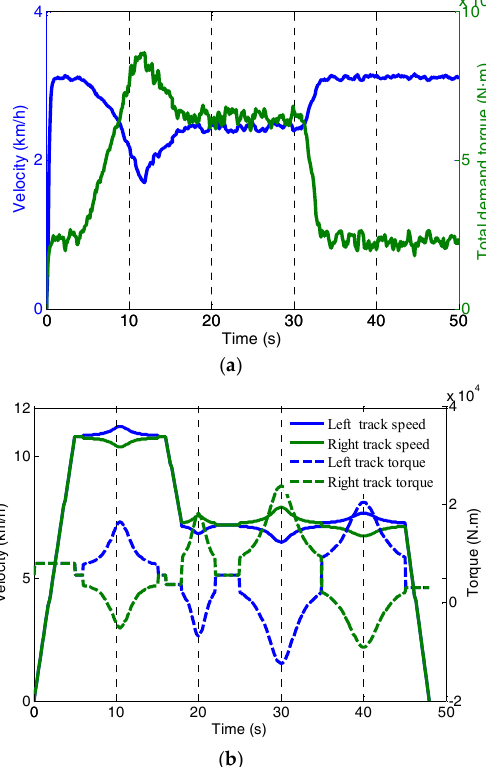
Figure 11. Driving cycles: ( a ) straight driving cycle; ( b ) turning cycle.